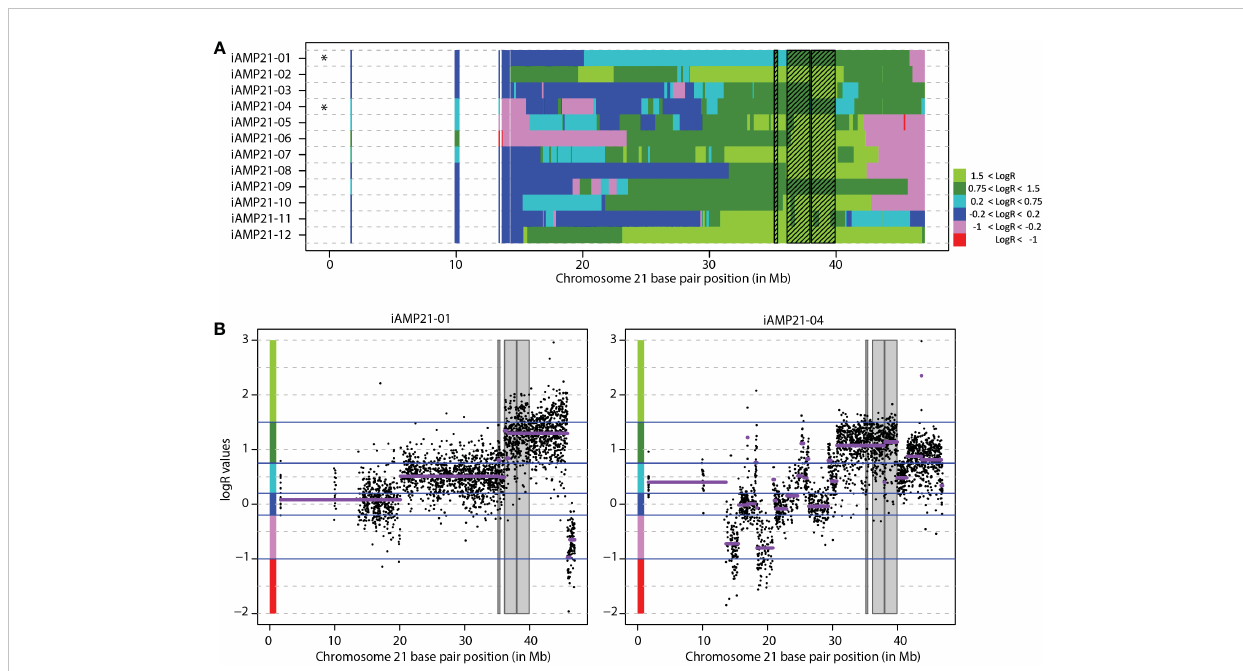
FIGURE 1 Determination of the common region of ampli fi cation in 12 iAMP21 cases. (A) Segmented chromosome 21 LogR values 12 copy number pro fi led iAMP21 cases. Each row depicts one case ordered randomly. Shaded region shows the common region of ampli fi cation in this cohort (CRA). Chromosome 21 base pair position is shown on the x-axis (reference genome hg18). Black stars depict cohort CRA de fi ning cases. (B) Chromosome 21 copy number pro fi le of the two cases that de fi ne the borders of the CRA. The y-axis shows normalized LogR values of individual probes (dots) and segmented LogR values (purple lines). Chromosome 21 base pair position is shown on the x-axis (reference genome hg18), with LogR value on the y-axis. Shaded region shows the CRA. Blue lines show the LogR value cut-offs as used in fi gure 1A, colours on the y-axis represent the colours as shown in fi gure